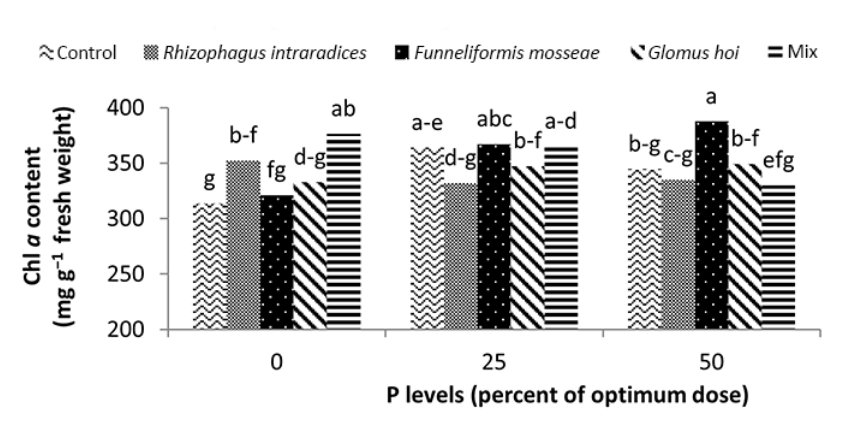
Figure 2 Effect of arbuscular mycorrhization and P fertilizer levels on chlorophyll a (Chl a ) content in peppermint.